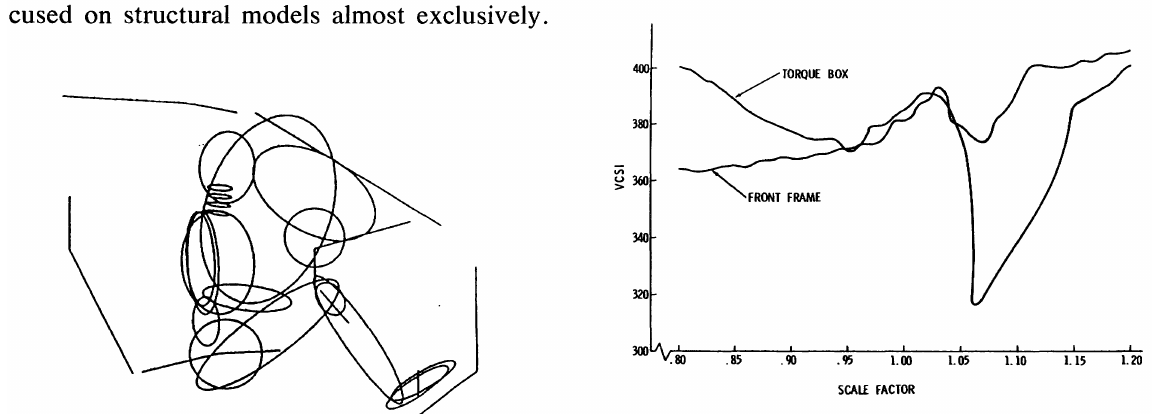
FIGURE 3 Yehicle crash severity index (YeSI) re sponse as a function of design variables (Bennett et aI.,